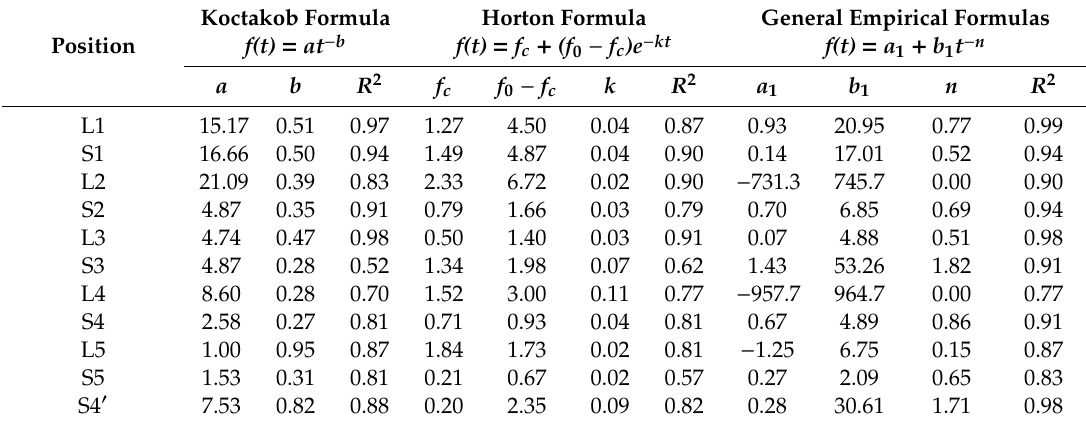
Table 3. The experiential parameters values of the three kind infiltration formulas. Koctakob Position